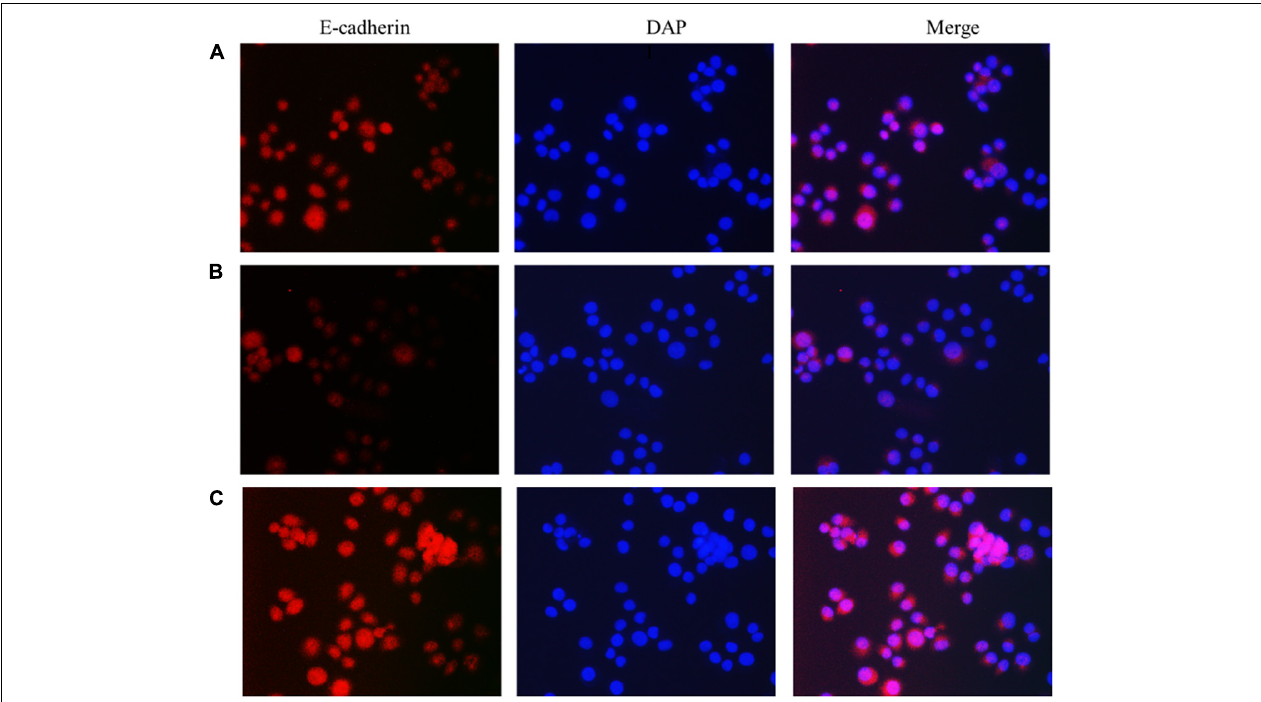
FIGURE 3 | The effect of lncRNA TPA overexpression and knockdown on the expression of MCF-7 E-cadherin antibody [200 × , (A) Normal breast cancer cells, (B) lncRNA TPA overexpression cells, (C) lncRNA TPA knockdown cells].